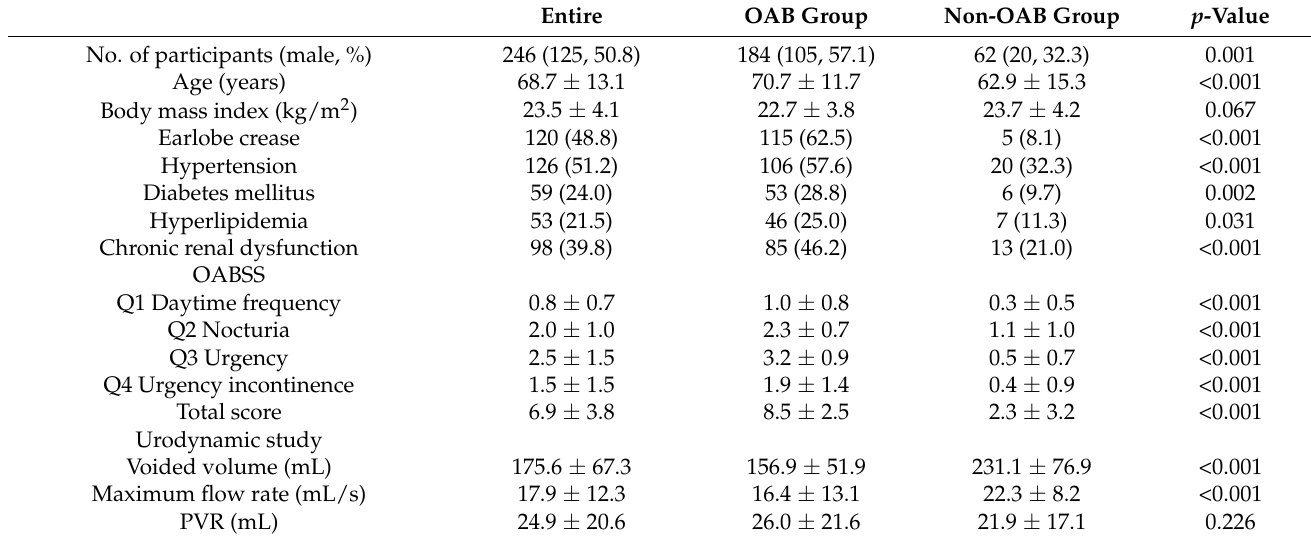
Table 1. General patient characteristics and differences between the two groups with or without OAB. Entire OAB Group Non-OAB Group p -Value